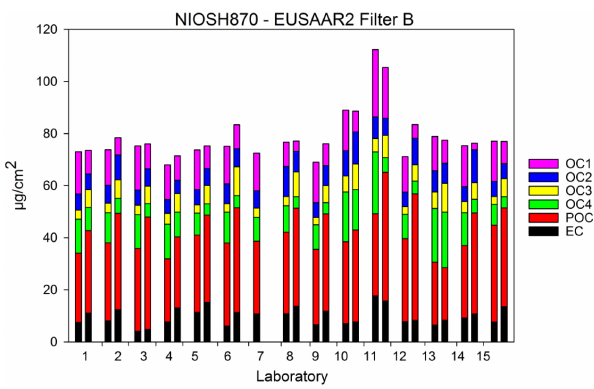
Figure 4. Thermograms of ECOC analysis on standard sucrose so- lution (S2), by NIOSH870 for all participants.